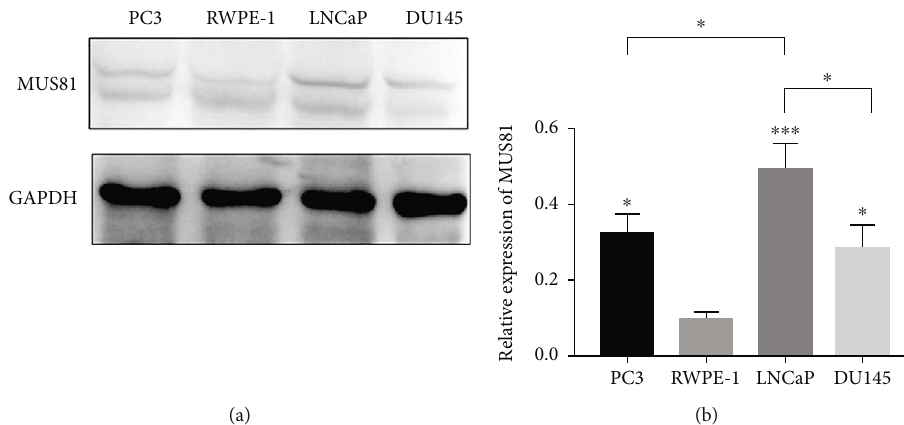
Figure 2: Di ff erences in protein expression levels of MUS81 in PC3, RWPE-1, LNCaP, and DU145 cells. (a) The relative MUS81 expression in PC3, RWPE-1, LNCaP, and DU145 cells was detected via western blot. (b) MUS81 protein expression in PC3, RWPE-1, LNCaP, and DU145 cells was detected via western blot. ∗ P < 0 : 05 and ∗∗∗ P < 0 : 001 , versus the expression of MUS81 in RWPE-1